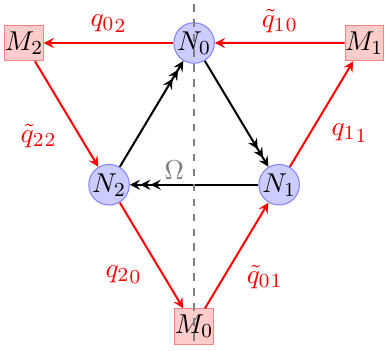
Figure 9. The quiver of C 3 = Z 3 with the addition of (cid:13)avour branes. P 3 (cid:15) ( I ) I =1 = (cid:0) 2 11 0 01 N